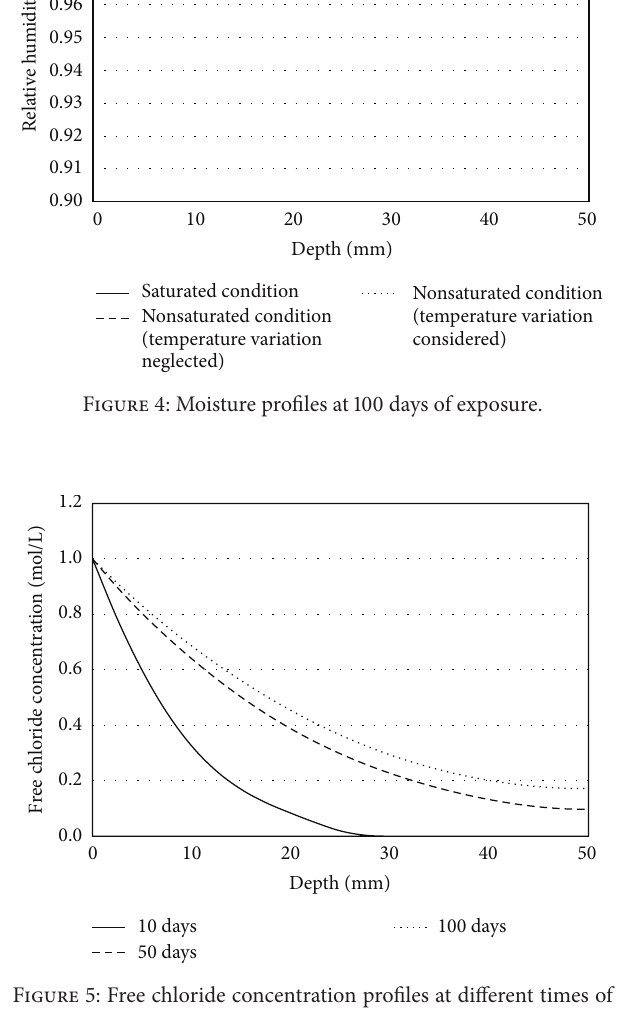
Figure 3: Moisture profiles at 50 days of exposure.